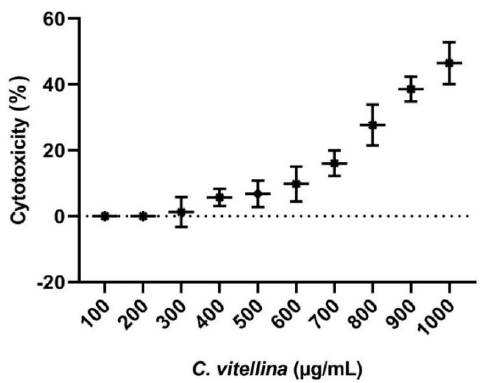
Figure 1. The effect of C. vitellina extract on HPBL cytotoxicity, 24 h, using MTT assay. Figure 1. The e ff ect of C. vitellina extract on HPBL cytotoxicity, 24 h, using MTT assay. Incubation with serial concentrations of the extract showed very weak toxicity with an IC 50 > 1000 µ g / mL. Data were represented as (Mean ± SD) of three di ff erent experiments (n =